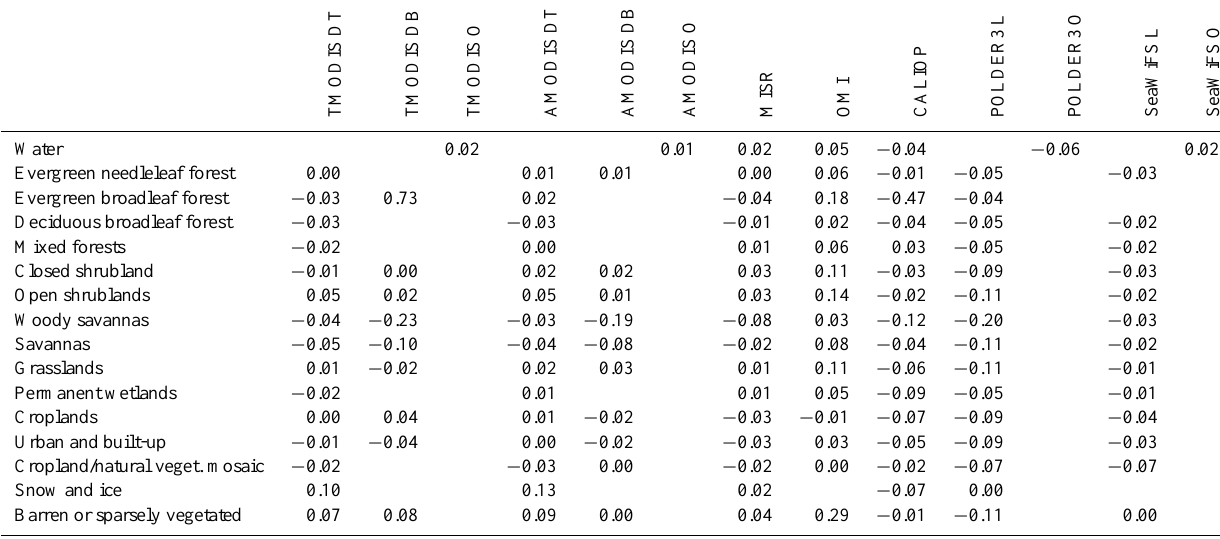
Table 6. Bias between the collocated spaceborne and ground-based observations of AOD estimated at the stations that coincide with different IGBP land cover types. Empty cells indicate no collocated data available from a specific sensor over a specific land cover type. No AERONET stations are available at the areas occupied by Deciduous needleleaf forest. The statistics were calculated based on the data that were pre- filtered by QA and screened of outliers as described in Sects. 4 and 5. A graphical representation of this table is in Fig. 14. Please see the Supplement for a breakdown of the listed statistics based on the nominal boreal seasons.